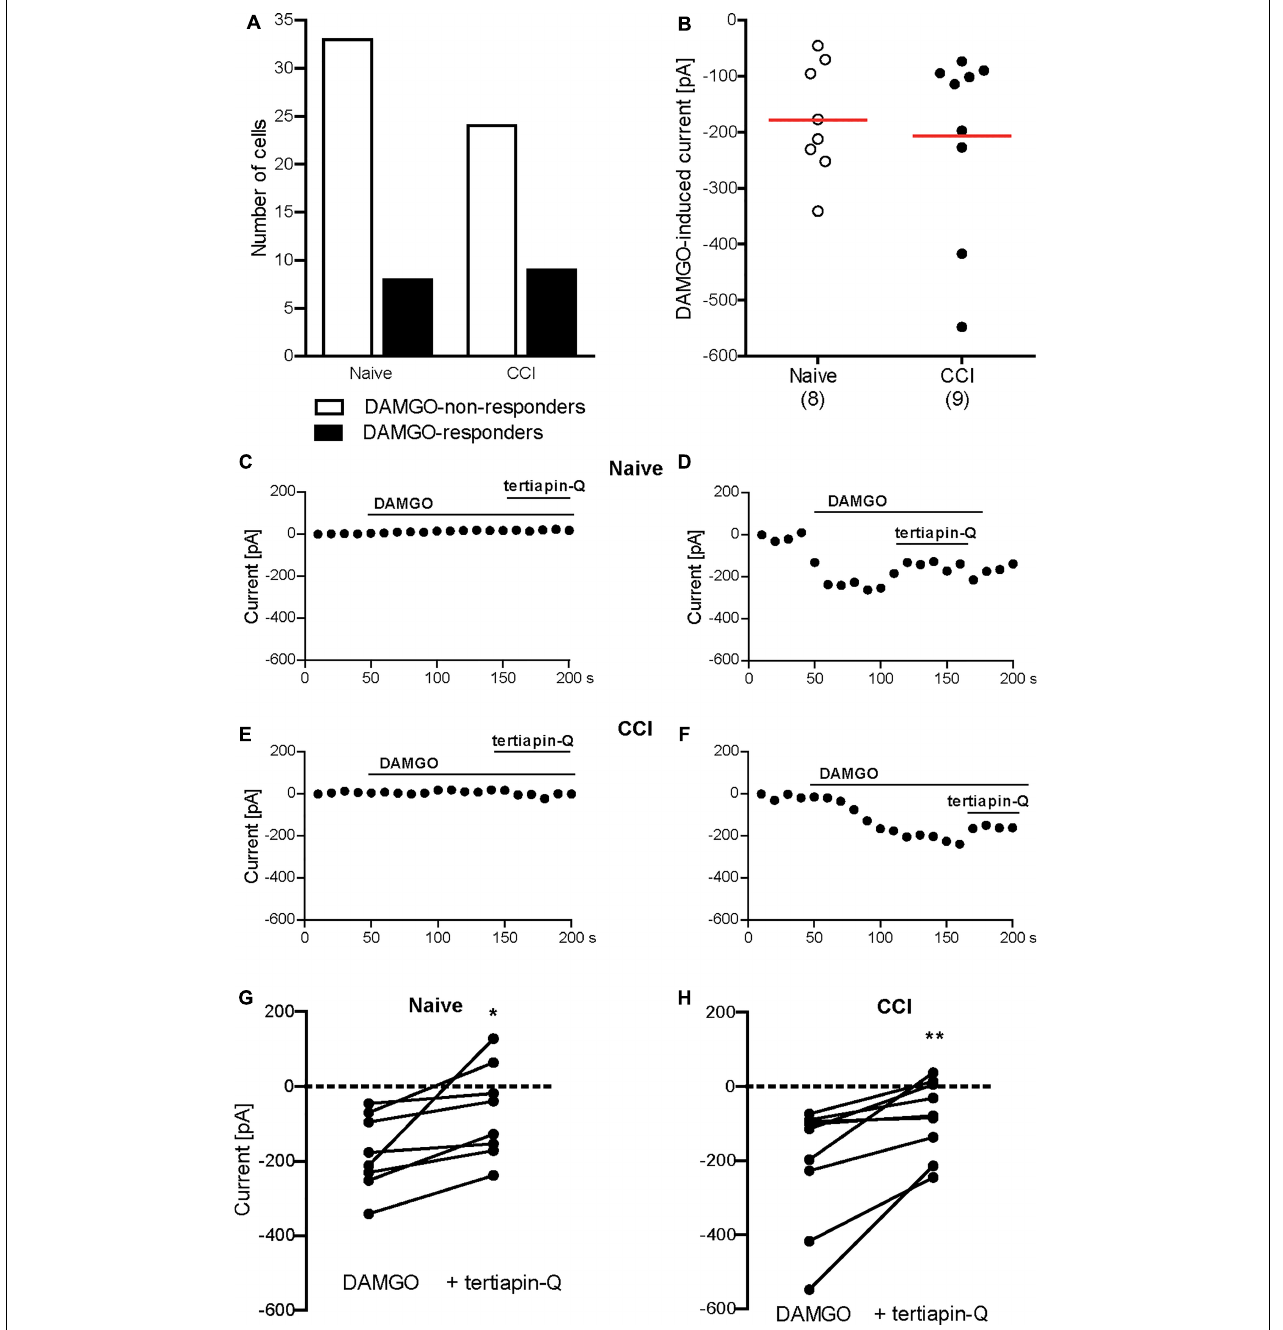
FIGURE 3 | DAMGO (10 µ M)-induced potassium currents in mouse DRG neurons obtained in the voltage ramp mode. (A) Number of neurons responding and non-responding to DAMGO from naïve and CCI mice. The proportion of DAMGO-responding to DAMGO-non-responding neurons from naïve vs. CCI mice did not differ significantly ( P = 0.596; Fisher’s exact t -test). The neurons were sampled from cultures obtained from DRG of seven naïve and eight CCI mice. (B) Single neuron currents in DAMGO-responders. The data points represent single neuron values, and the red horizontal lines indicate the means. Numbers in brackets indicate the number of neurons. (C–F) Exemplary currents of DRG neurons non-responding (C) and responding (D) to DAMGO from naïve mice, and DRG neurons non-responding (E) and responding (F) to DAMGO from mice on day 2 following CCI. The DAMGO effects are shown before and during tertiapin-Q (100 nM) application. (G,H) Tertiapin-Q (100 nM)-mediated attenuation of DAMGO-induced currents in individual neurons from naïve mice ( n = 8 neurons; ∗ P = 0.0204, paired t -test) (G) and CCI mice ( n = 9 neurons; ∗∗ P = 0.0073, paired t -test) (H) . Only DAMGO-responding neurons are shown. Data points represent DAMGO-induced currents of the same neuron before and after application of tertiapin-Q. Dotted lines represent zero current. In all experiments, the currents were obtained by voltage ramps from a holding potential of –40 mV and measured at –80 mV in high potassium extracellular buffer (45 mM). Neurons were defined as responding to DAMGO if the resulting current was larger than three times the noise